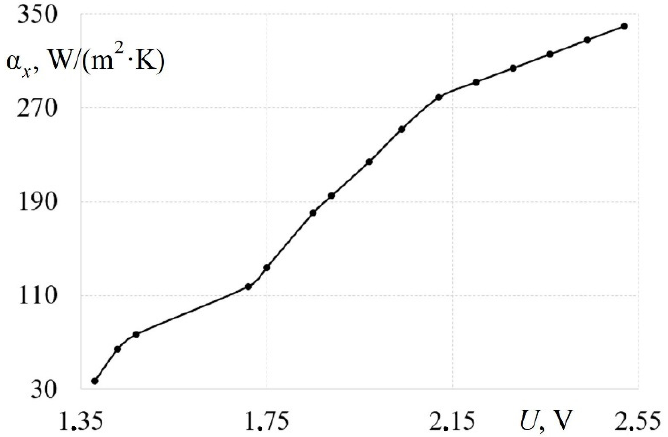
Figure 3. Calibration dependence for determining the local heat transfer coefficients in the pipe.